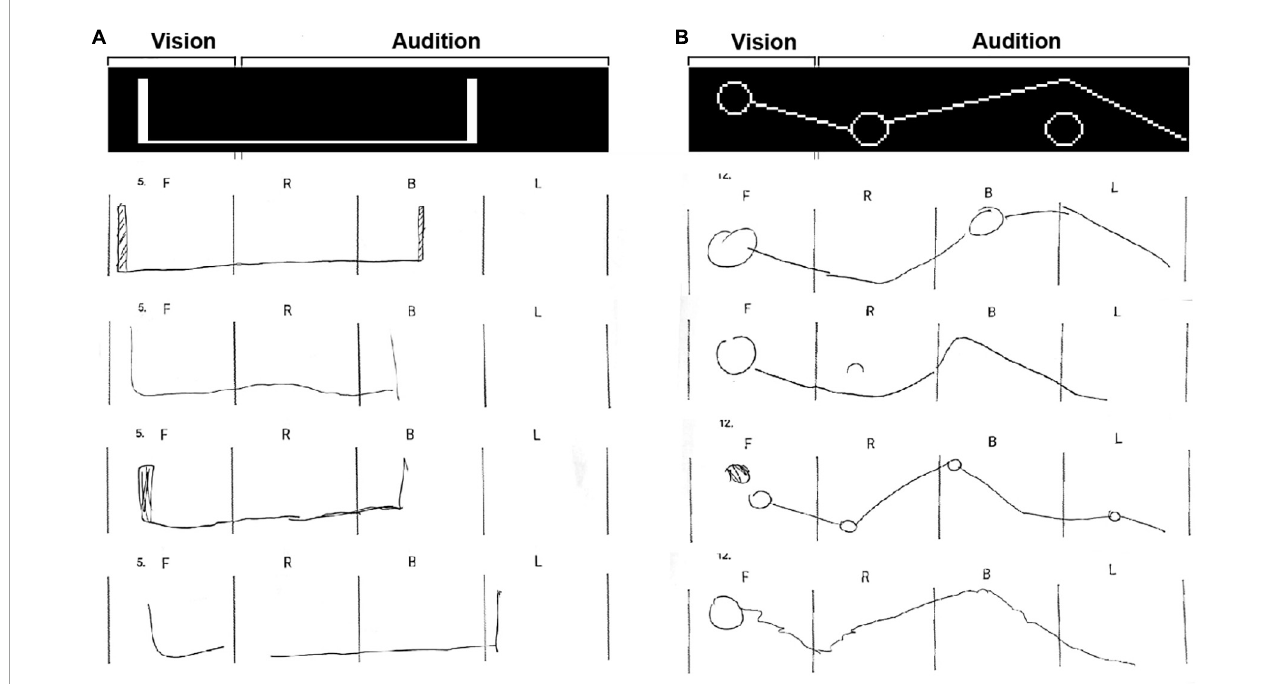
FIGURE3 Two examples of the drawing task stimuli with 8 participants’ drawings. (A) Example of expanded single shapes type of stimuli. The group score for the number of shapes was 85 ± 24.6%, the score for the accuracy of the shapes themselves was 83 ± 24.4%, the group score for the proper positioning of the shapes was 86.7 ± 29.7%, and the group score for the unified visual-auditory shape was 70 ± 45.5%. (B) Example of a stimulus from category 3 (combining expanded and trained shapes in tandem). The group score for the number of shapes was 77.7 ± 10.3%, the score for the accuracy of the shapes themselves was 43.7 ± 17%, the group score for the proper positioning of the shapes was 66 ± 14.6%, and the group score for the unified visual-auditory shape was 65.3 ±